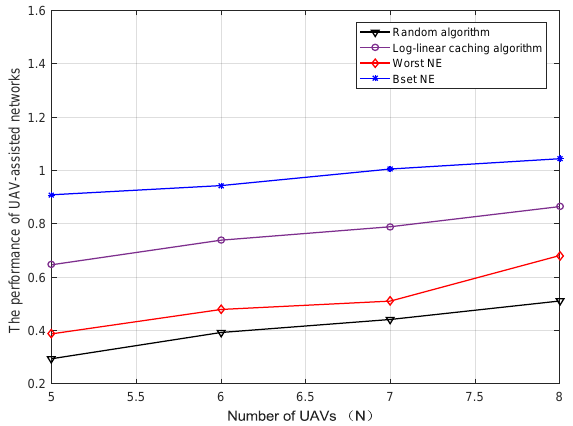
Figure 5. The performance of UAV-assisted networks versus the number of UAVs in service ( | f | = 6 and | c n | =